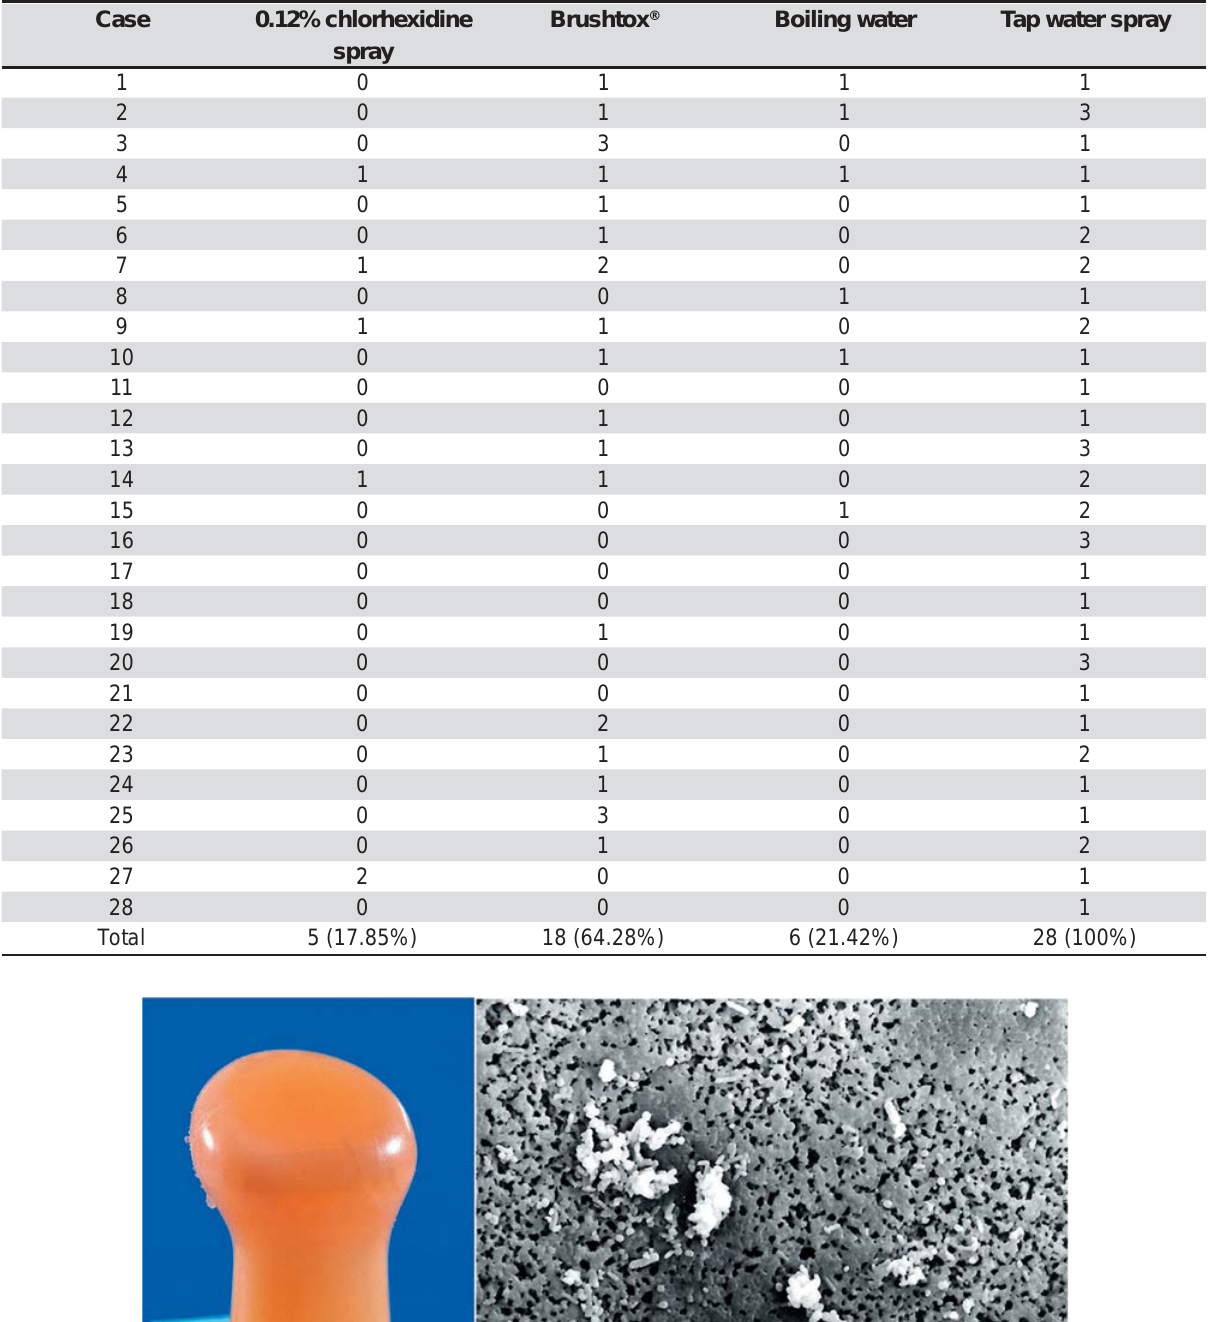
Table 1- (cid:3)(cid:49)(cid:88)(cid:80)(cid:69)(cid:72)(cid:85)(cid:3)(cid:82)(cid:73)(cid:3)(cid:70)(cid:82)(cid:79)(cid:82)(cid:81)(cid:76)(cid:72)(cid:86)(cid:18)(cid:69)(cid:76)(cid:82)(cid:191)(cid:79)(cid:80)(cid:86)(cid:3)(cid:82)(cid:73)(cid:3) mutans streptococci (cid:3)(cid:70)(cid:82)(cid:88)(cid:81)(cid:87)(cid:72)(cid:71)(cid:3)(cid:82)(cid:81)(cid:3)(cid:87)(cid:75)(cid:72)(cid:3)(cid:86)(cid:88)(cid:85)(cid:73)(cid:68)(cid:70)(cid:72)(cid:3)(cid:82)(cid:73)(cid:3)(cid:83)(cid:68)(cid:70)(cid:76)(cid:191)(cid:72)(cid:85)(cid:86)(cid:3)(cid:88)(cid:86)(cid:72)(cid:71)(cid:3)(cid:73)(cid:82)(cid:85)(cid:3)(cid:26)(cid:3)(cid:71)(cid:68)(cid:92)(cid:86)(cid:15)(cid:3)(cid:68)(cid:70)(cid:70)(cid:82)(cid:85)(cid:71)(cid:76)(cid:81)(cid:74)(cid:3) to the scores attributed for each disinfection: 0.12% chlorhexidine solution spray, Brushtox ® Antiseptic Toothbrush Cleanser